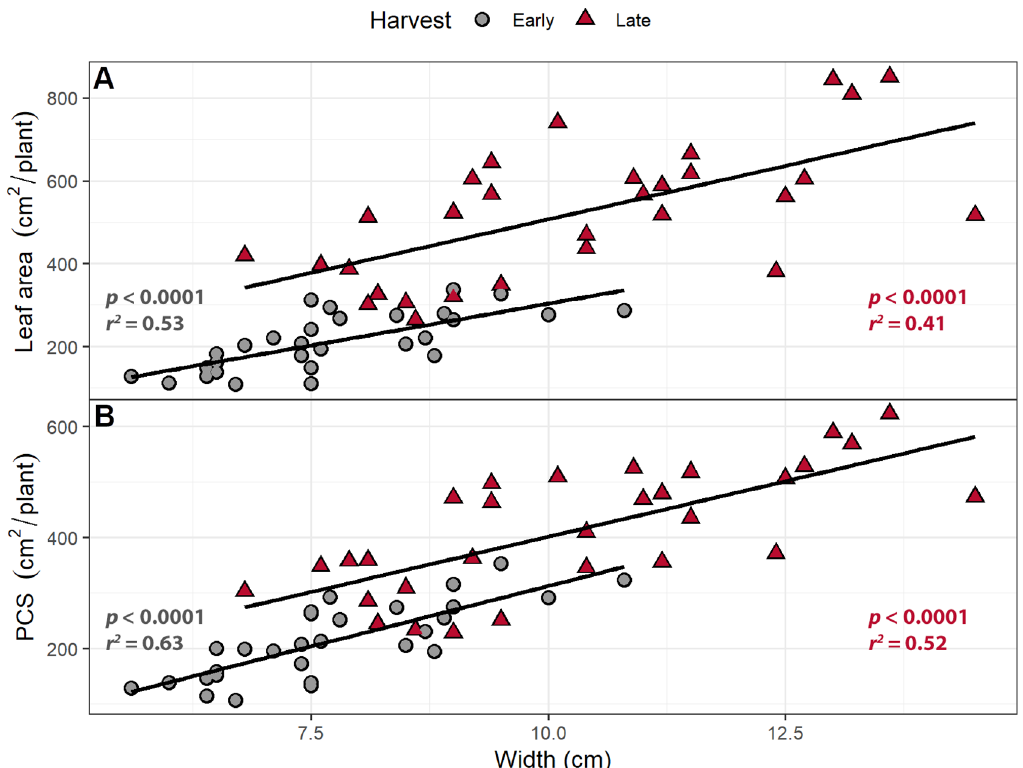
Figure 7. The relationship between leaf width and ( A ) leaf area and ( B ) projected canopy size (PCS). “Green Salad Bowl” lettuce ( Lactuca sativa ) were grown under a photosynthetic photon flux density ranging from 111 to 245 µmol m − 2 s − 1 supplemented with a far-red gradient which ranged from 4.7 to 32.8 µmol m − 2 s − 1 . The early harvest occurred 16 days after germination, while the late harvest occurred 25 days after germination.